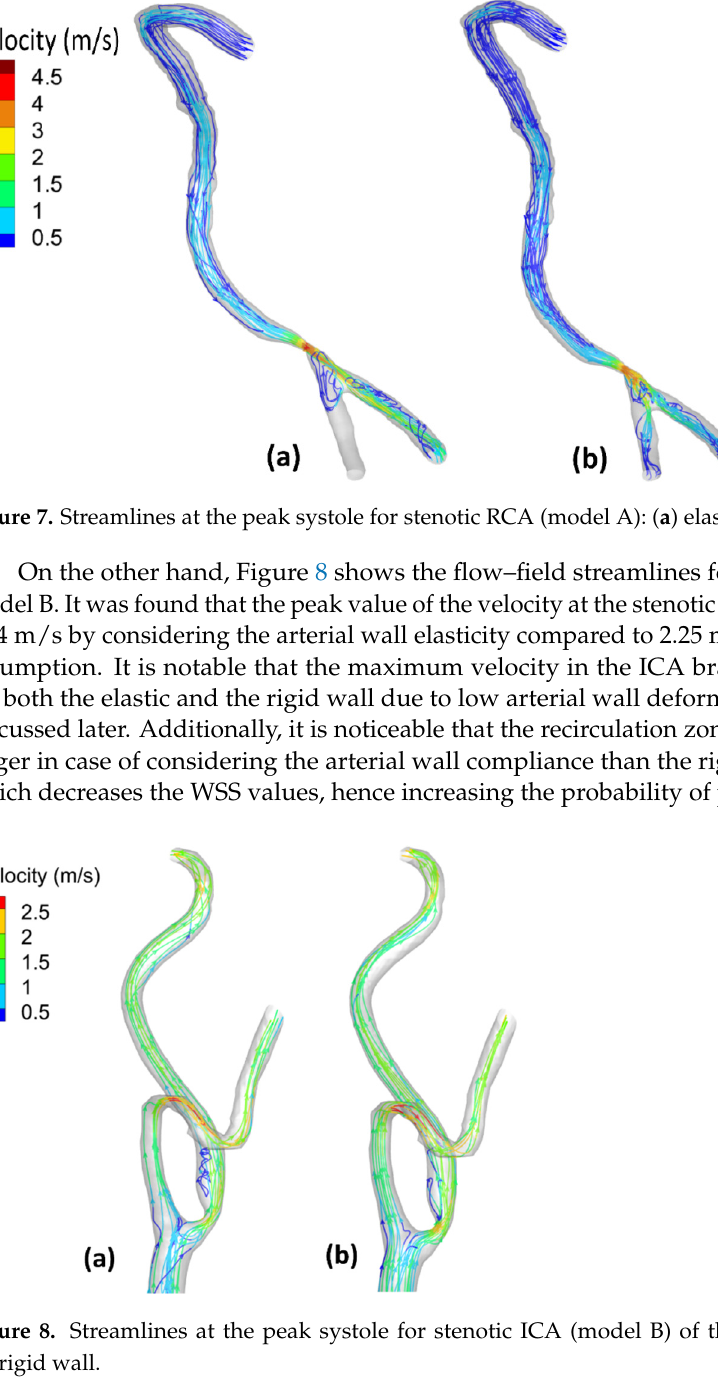
Figure 8. Streamlines at the peak systole for stenotic ICA (model B) of the CA: ( a ) elastic wall, ( b ) rigid wall.